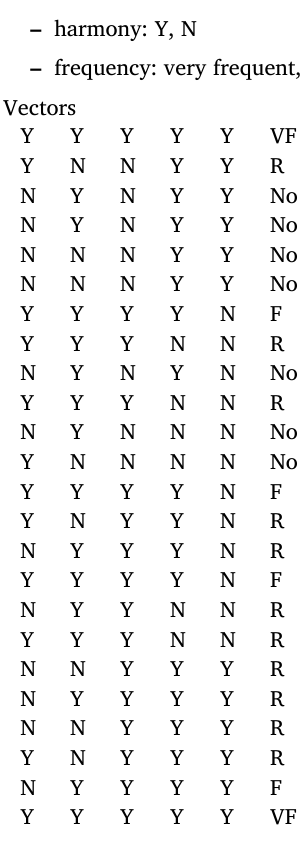
Figure 4: Dryer’s feature vectors. (See the text for